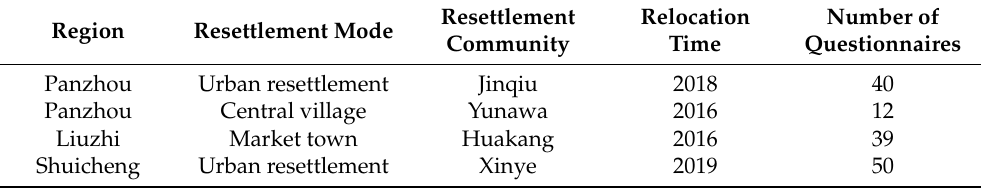
Table 2. Study area